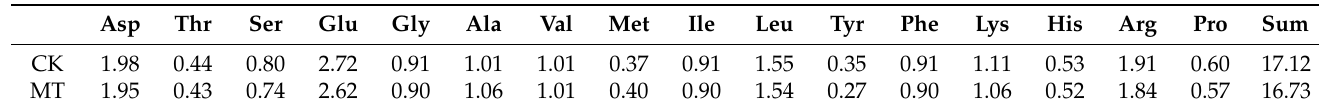
Table 6. The free amino acid content (mg/100 g) of untreated adzuki beans and microwave pre- cooked adzuki beans.